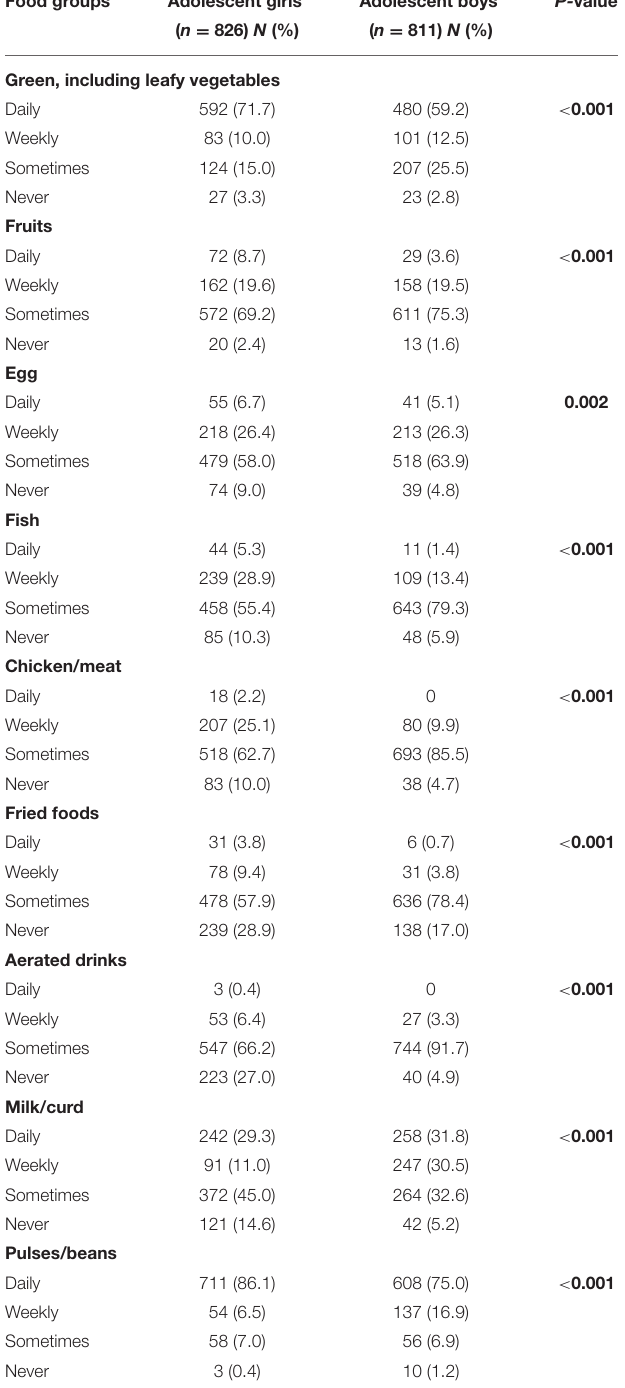
TABLE 2 | Percent distribution of adolescents by frequency of consumption of specific food groups. Food groups